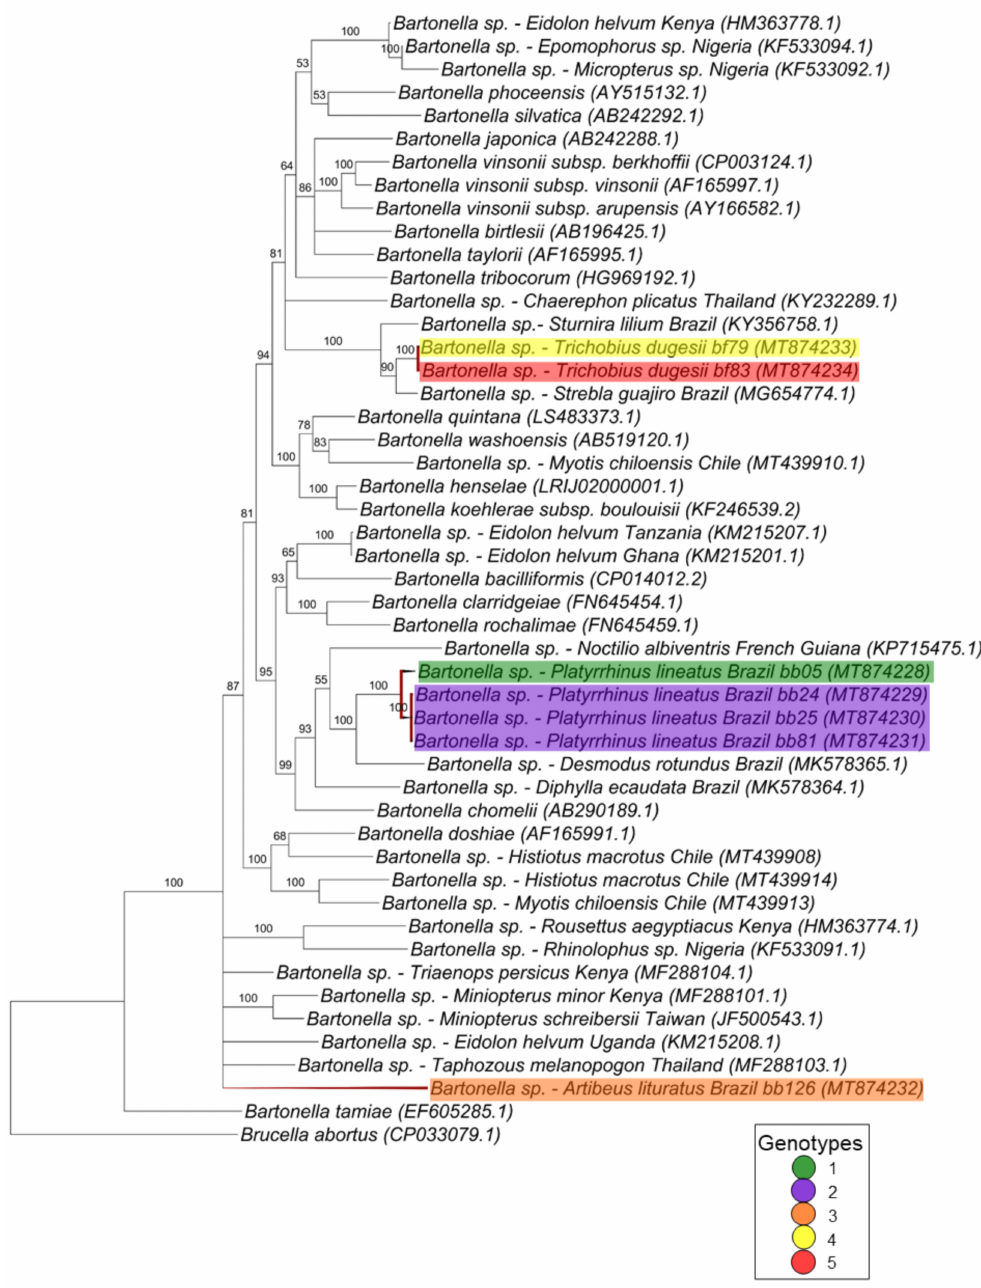
Figure 5. Phylogenetic tree based on an alignment of 757 bp-length of Bartonella spp. rpoB sequences, using the Bayesian Inference method and TrN + I + G as the evolutionary model. Numbers at nodes correspond to the posterior probability value support. Each sequence is highlighted according to its respective genotype. Each sample is designated with the type of sample (bb = bat blood and bf = bat fly) followed by the referred animal